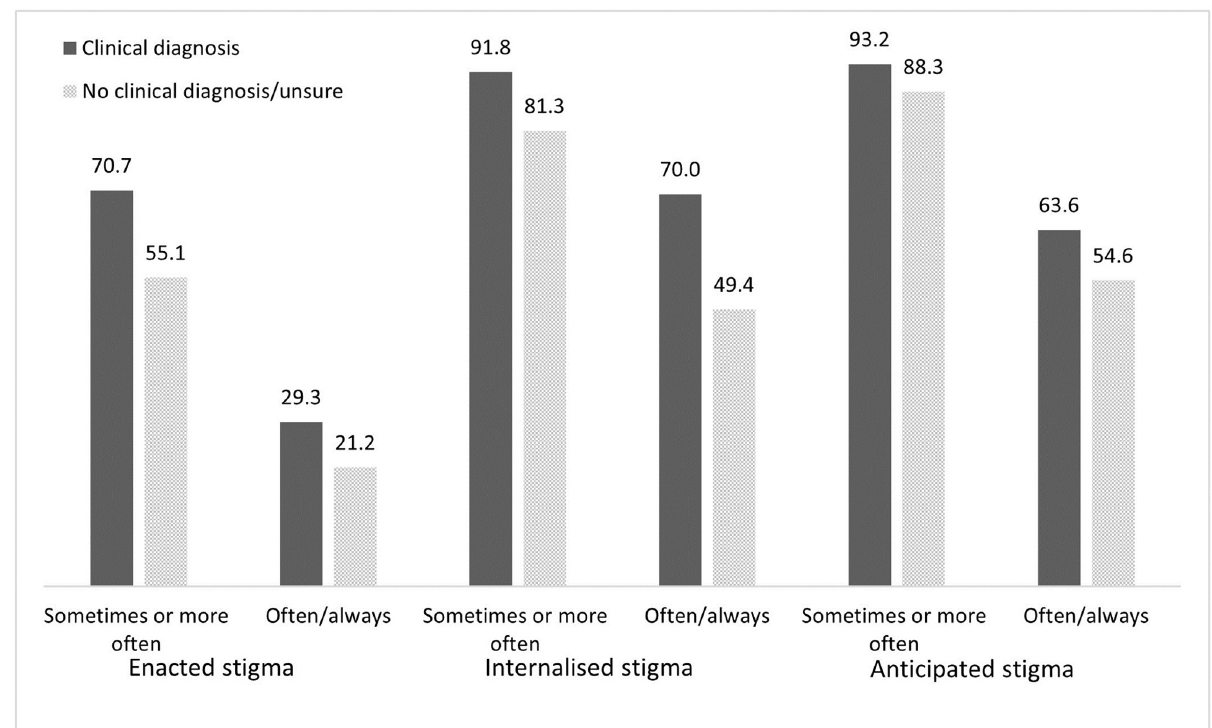
Fig 1. Prevalence estimates of stigma among people with diagnosed and undiagnosed Long Covid.